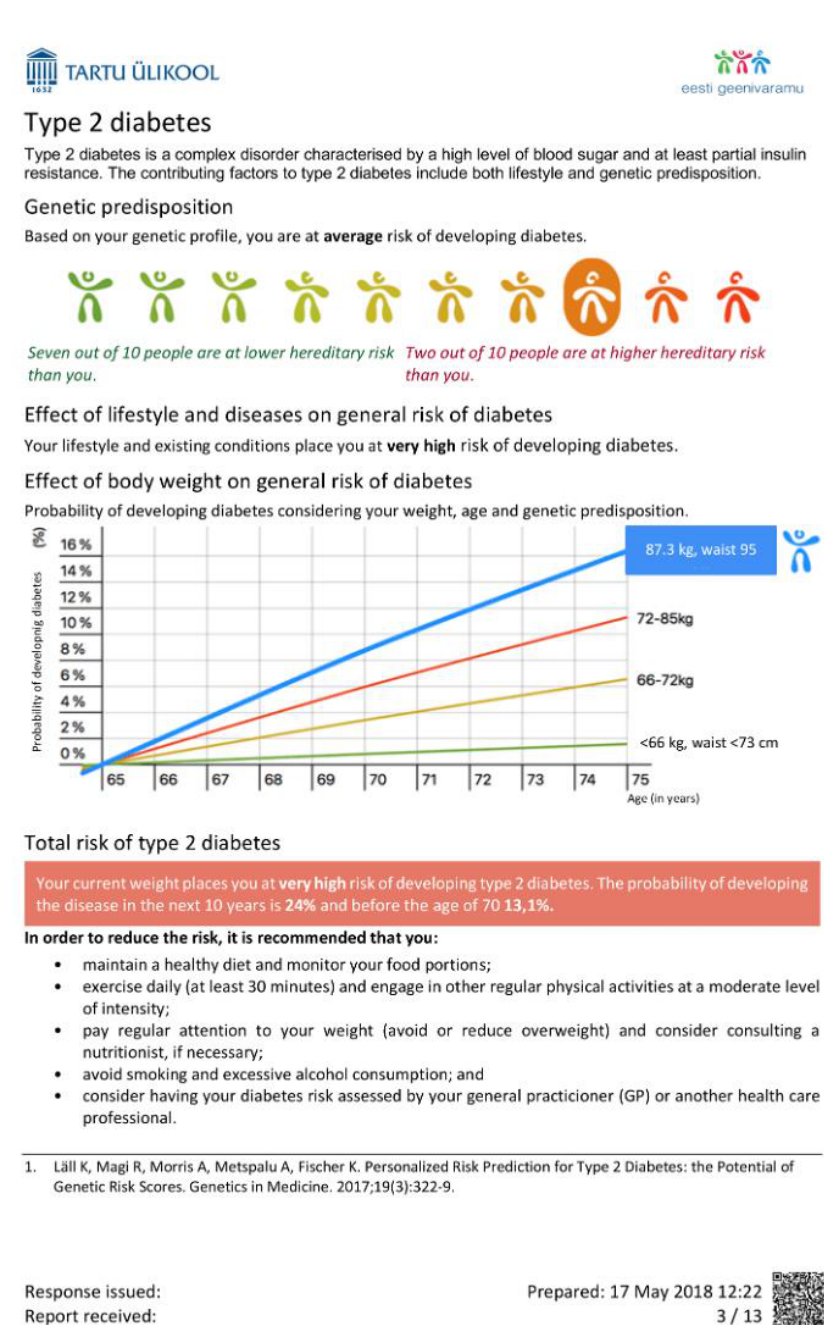
Figure 4. Example page in the concept report for an Estonian biobank participant. In a personal- ized report, the participant will receive information on how her/his risk of the disease will increase as a function of age, how much the genetic component has contributed to risk and to what extent it could be altered by lifestyle modifications or medical intervention.